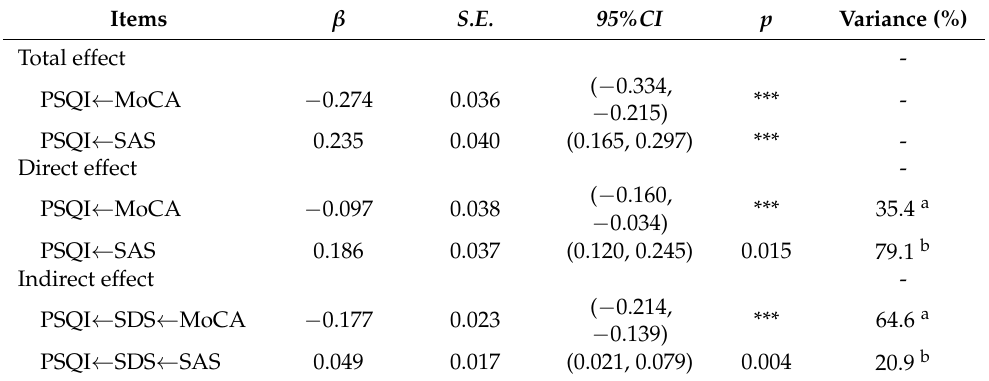
Table 4. Total, direct, and mediated effects on PSQI.